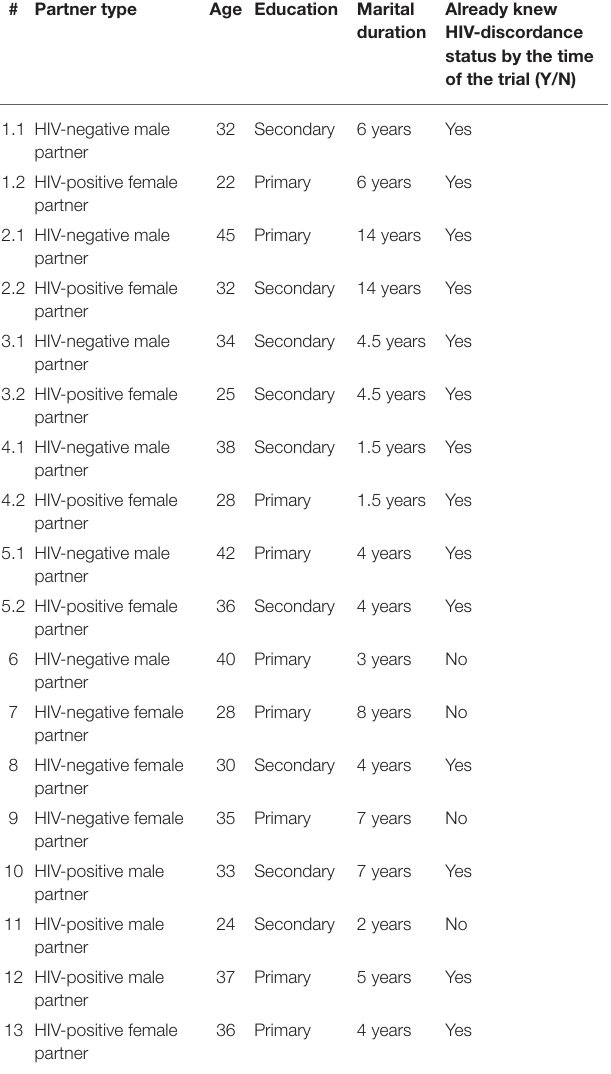
TABLE 1 | Characteristics of the eighteen individuals interviewed for this